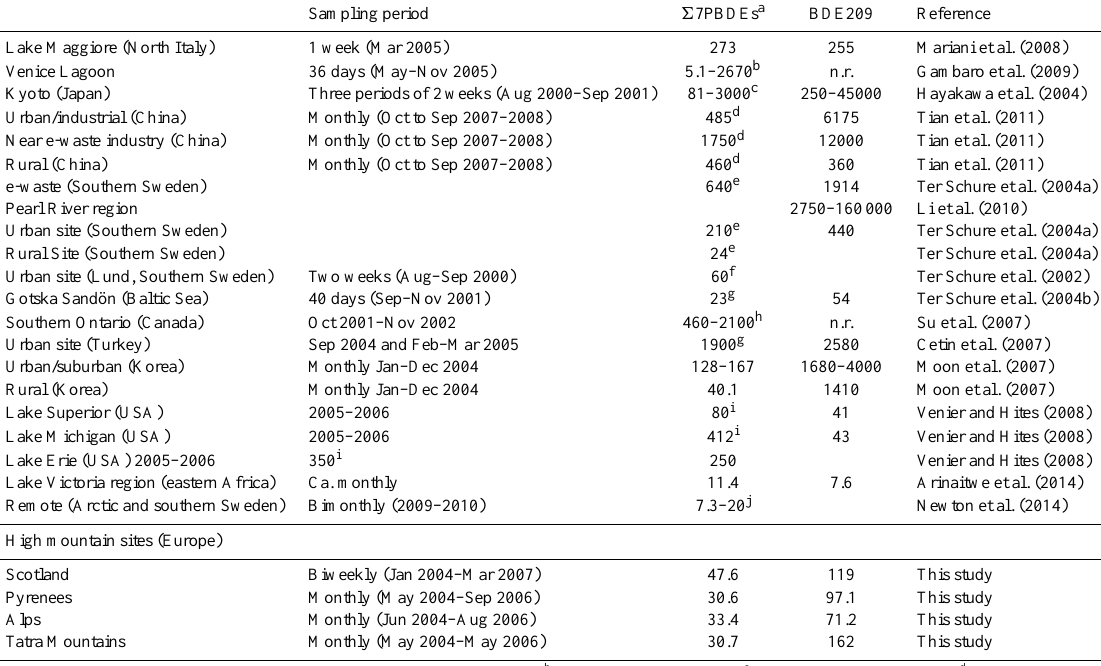
Table 4. Comparison of PBDE deposition fluxes in high mountain sites of Europe with those reported in the literature (units: ngm − 2 mo − 1 ) .